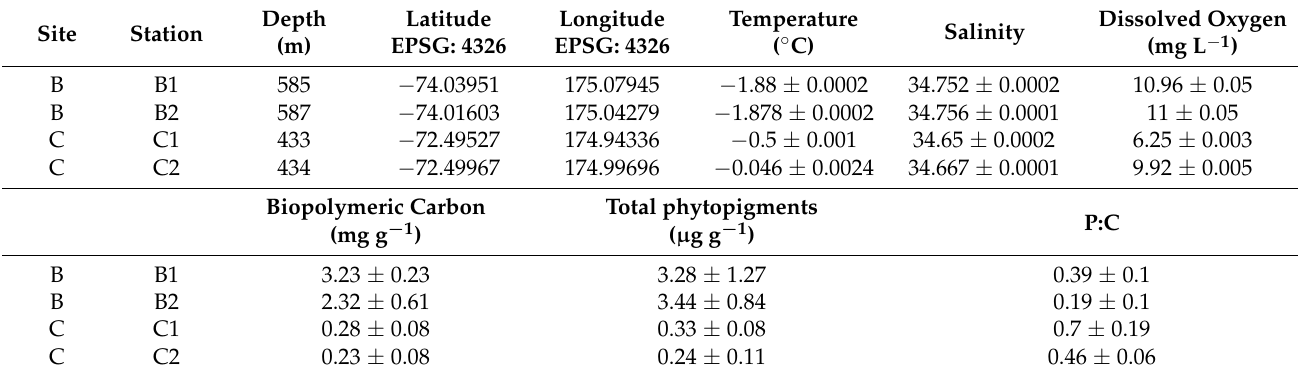
Table 1. Values of temperature, salinity and dissolved oxygen concentrations of the bottom waters and biopolymeric carbon and total phytopigment concentrations and protein to carbohydrate ratios (P:C) in the surface sediments of the different stations investigated. Mean values and standard deviations ( ± ) are